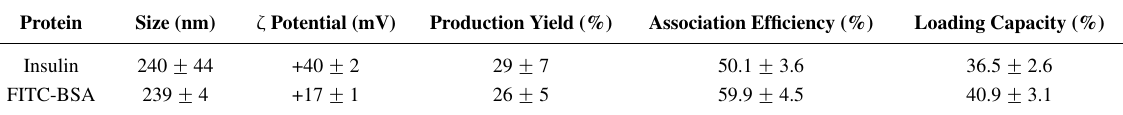
Physicochemical characteristics, production yield, association efficiency and loading capacity of insulin- and FITC-BSA-loaded CS/CHS (3/1, w/w) nanoparticles (mean ˘ SD, n ě 4). Protein Size (nm) ζ Potential (mV) Production Yield (%) Association Efficiency (%) Loading Capacity (%) Insulin 240 ˘ 44 +40 ˘ 2 29 ˘ 7 50.1 ˘ 3.6 FITC-BSA 239 ˘ 4 +17 ˘